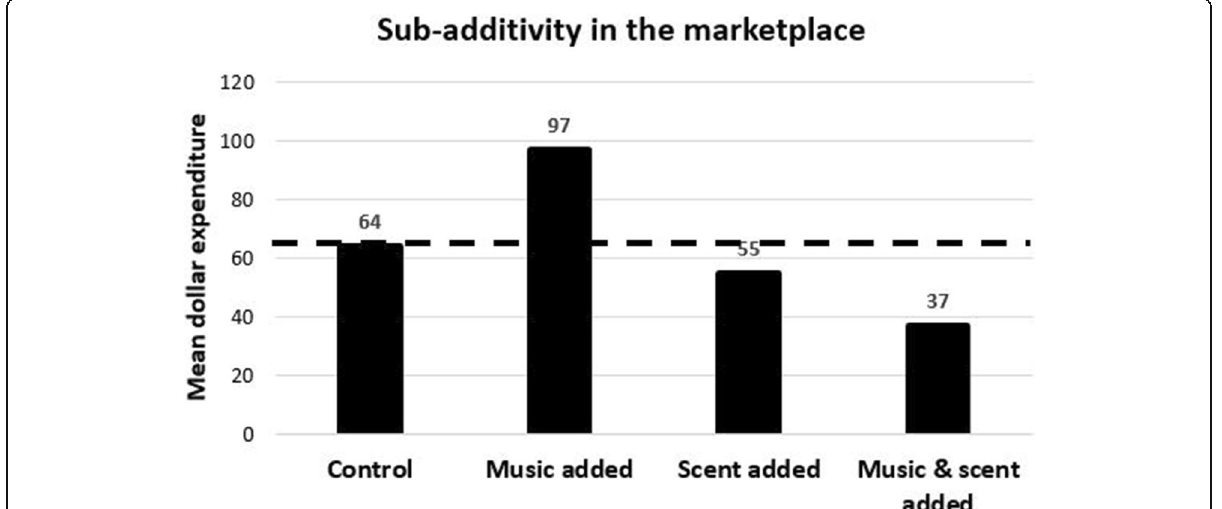
Fig. 9 Morrin and Chebat (2005). Sales figures (unplanned purchases) in mall as a function of music, scent, or the combination of the two. In this case, multisensory stimulation led to a significant reduction in sales, perhaps because low-tempo music was combined with a likely-alerting citrus